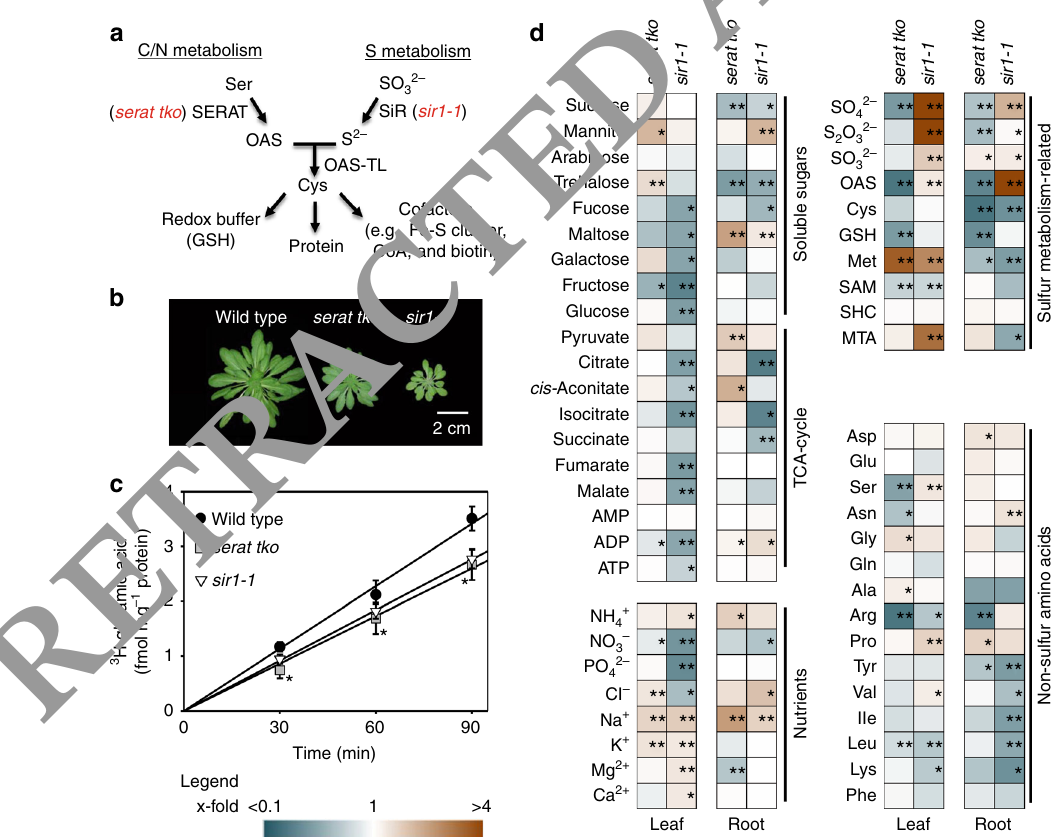
Fig. 1 Limitation of OAS or sul fi de for Cys biosynthesis results in decreased translation and distinct metabolic phenotype. a Metabolic pathway of cysteine biosynthesis. b Rosette phenotype of 7-week-old wild-type serat tko and sir1-1 grown in hydroponic culture. Scale bar, 2 cm. c Global translation rate in different genotypes as determined by time-resolved incorporation of 3 H-glutamic acid into proteins ( n = 3, mean ± s.e.m., one-way ANOVA, * p < 0.05). d Relative fold change of metabolites is depicted as a heat map in cysteine-synthesis-depleted mutants compared to wild type ( n = 3 – 4, one-way ANOVA, * p < 0.05, ** p <